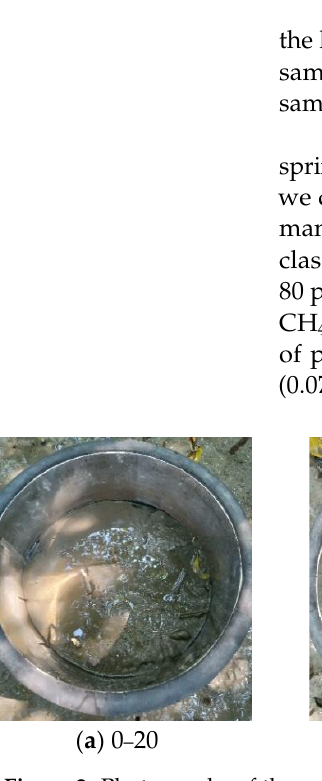
Figure 2. Photographs of the pneumatophores of A. marina within the chambers (diameter = 30 cm): ( a ) 0 – 20, ( b ) 20 – 50, ( c ) 50 – 80, and ( d ) >80 pneumatophores (unit: number of pneumatophores in 0.071 m 2 ).